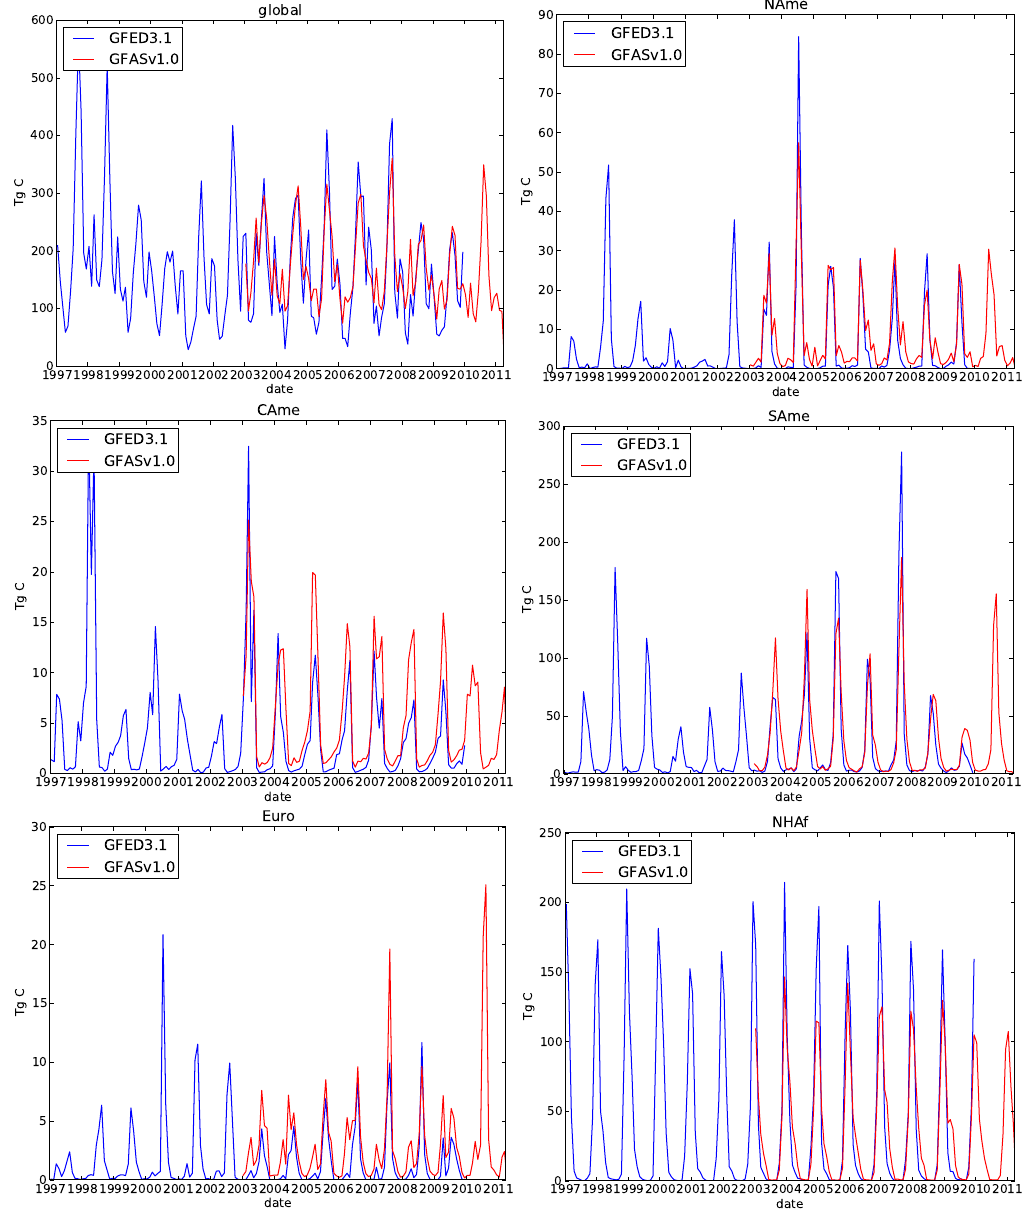
Fig. 6. Monthly carbon emissions in GFASv1.0 and GFED3.1 for the entire globe and several regions as defined in Table 4.